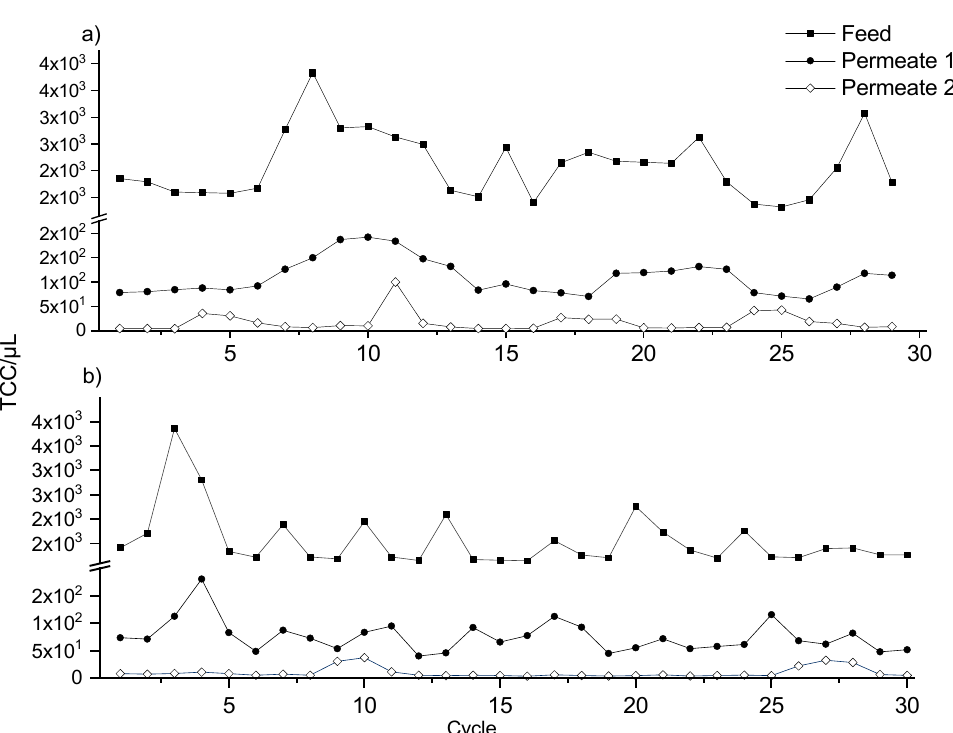
Figure 6. Continuous determination of total cell count (TCC) in flocculated Elbe River water (feed), Permeate 1 and Permeate 2, ( a ) 9–12 November 2018, ( b ) 19–22 November 2018), samples were stained with SYBER® Green.